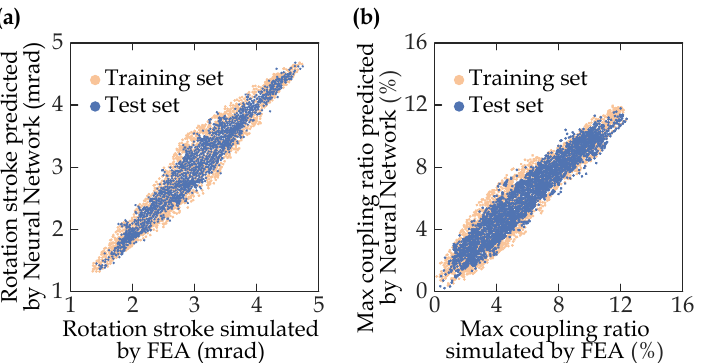
Figure 4. Comparisons of the one-axis rotation stroke and maximum coupling ratio between results by neural network model and FEA. ( a ) Rotation stroke in y -axis actuation. ( b ) Maximum coupling ratio in y -axis actuation.